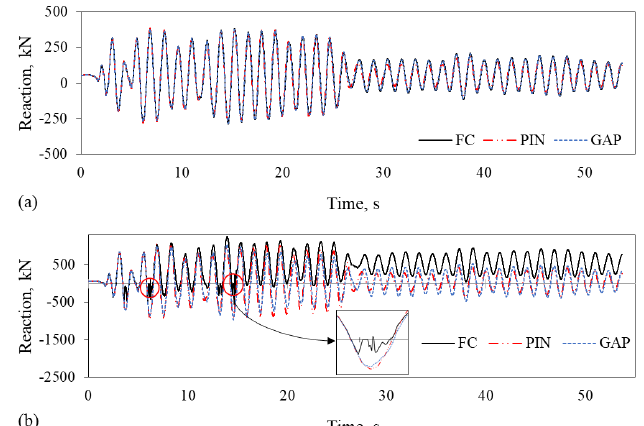
Figure 13. Horizontal reaction of landside leg: ( a ) at S a = 0.2 g; ( b ) at S a = 0.6 g.